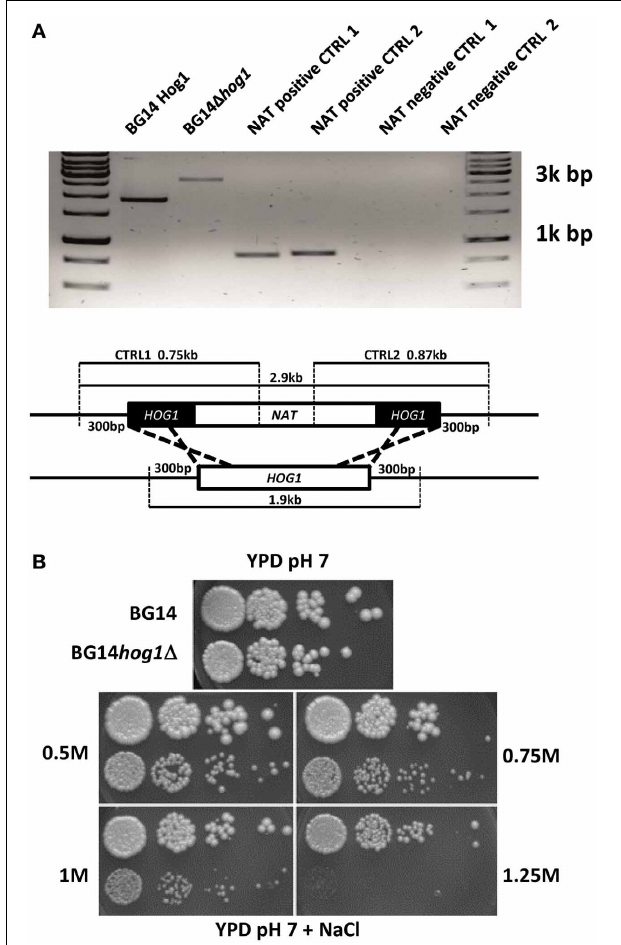
FIGURE 1 | (A) Confirmation of the integration of the marker cassette in to the Cg HOG1 locus. The genomic locus and primer binding sites is indicated. (B) C. glabrata Hog1 is required for osmotic stress tolerance. BG14, BG14 hog1 (cid:2) , and BG14 carrying pHog1-GFP were diluted and spotted on YPD containing the indicated amount of NaCl. Growth was recorded after about